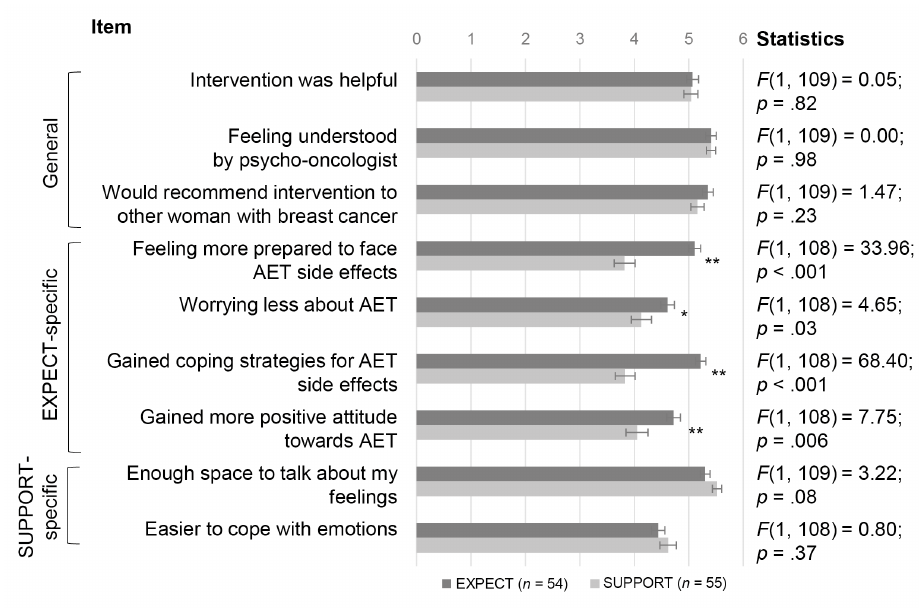
Patients’ Evaluation of EXPECT and SUPPORT